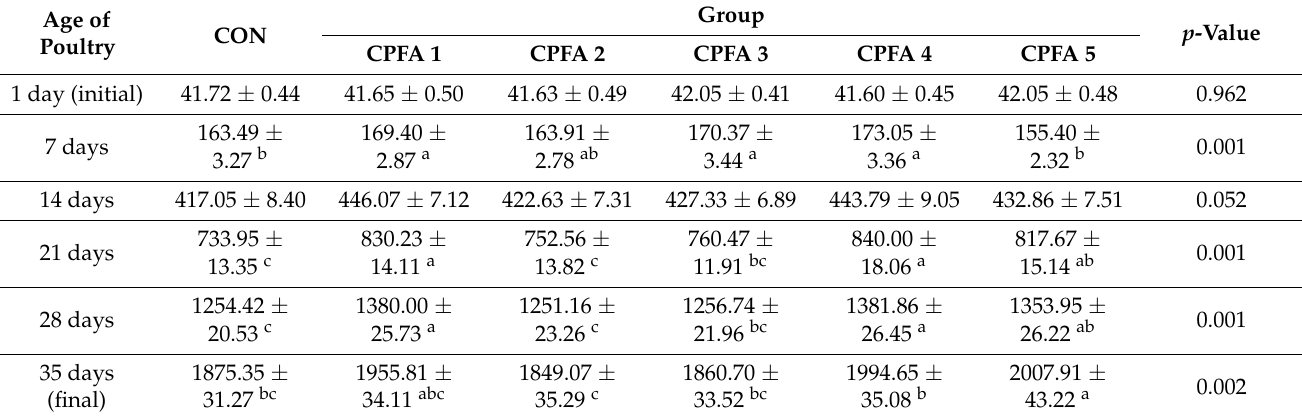
Table 4. Dynamics of live weight of broiler chickens,